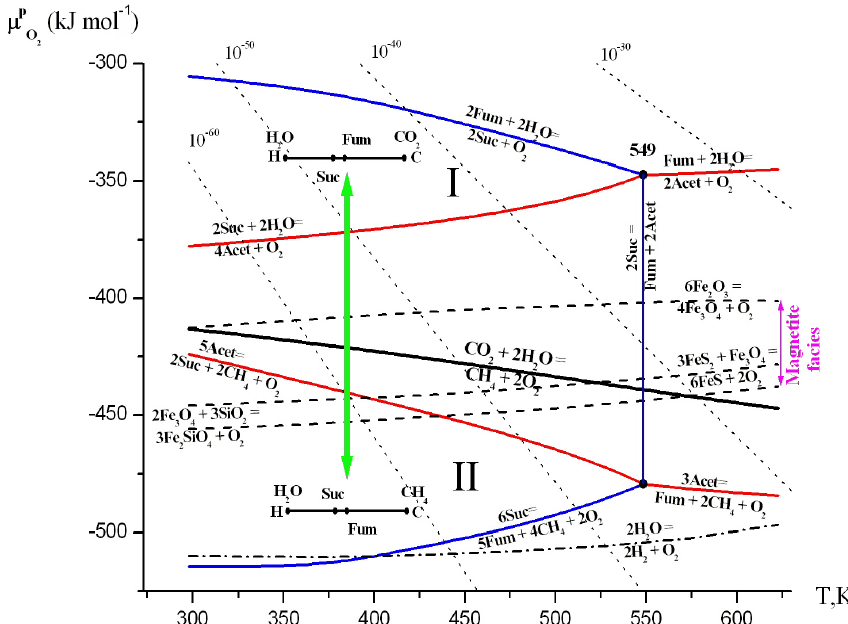
Figure 3. Diagram of the chemical potential of oxygen ( µ P ) and temperature ( T , K) at saturated vapor pressure ( P SAT ). The areas of O 2 thermodynamic stability of substances and their parageneses were calculated according to the method described in Korzhinskii (1959) and Marakushev and Belonogova (2009). Points (indicated by temperature values) and lines represent four-phase and three-phase equilibria, separating the two-phase divariant fields of substance stabilities. The bold black line represents the equilibrium of CO 2 ↔ CH 4 and separates their areas of thermodynamic stability (I and II). The dashed lines are equilibria of mineral buffers: hematite–magnetite, Fe 2 O 3 / Fe 3 O 4 (HM); pyrite–pyrrhotite–magnetite, FeS 2 + Fe 3 O 4 / FeS (PPM); and quartz–magnetite–fayalite, SiO 2 + Fe 3 O 4 / Fe 2 SiO 4 (QMF). The isolines of the activity of O 2 (10 − n M, dotted lines) are drawn. The acetate and succinate facies are contoured with red and blue equilibria, respectively. We provide only two linear diagrams of the two-component C–H system in the CO 2 and CH 4 facies. The transition between this facies with the change of chemical potential of oxygen is indicated by a green arrow. Abbreviations are as follows: succinate – Suc, fumarate – Fum – and acetate